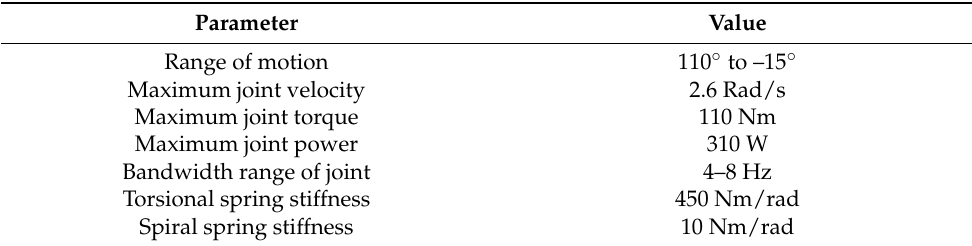
Table 1. Actuator design requirements.